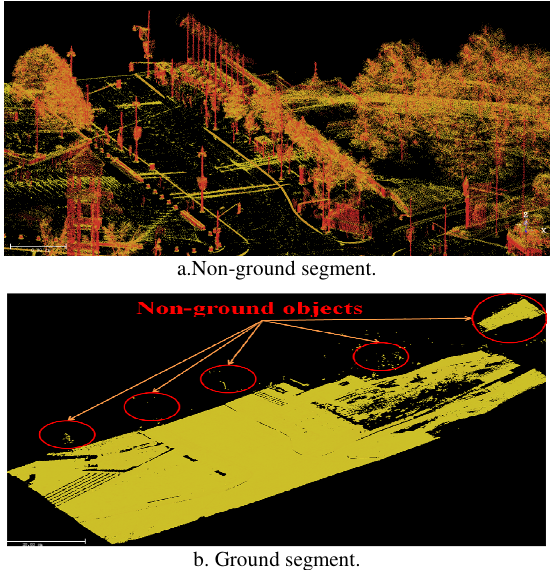
b. Ground segment. Figure 6. Segmentation result of the second